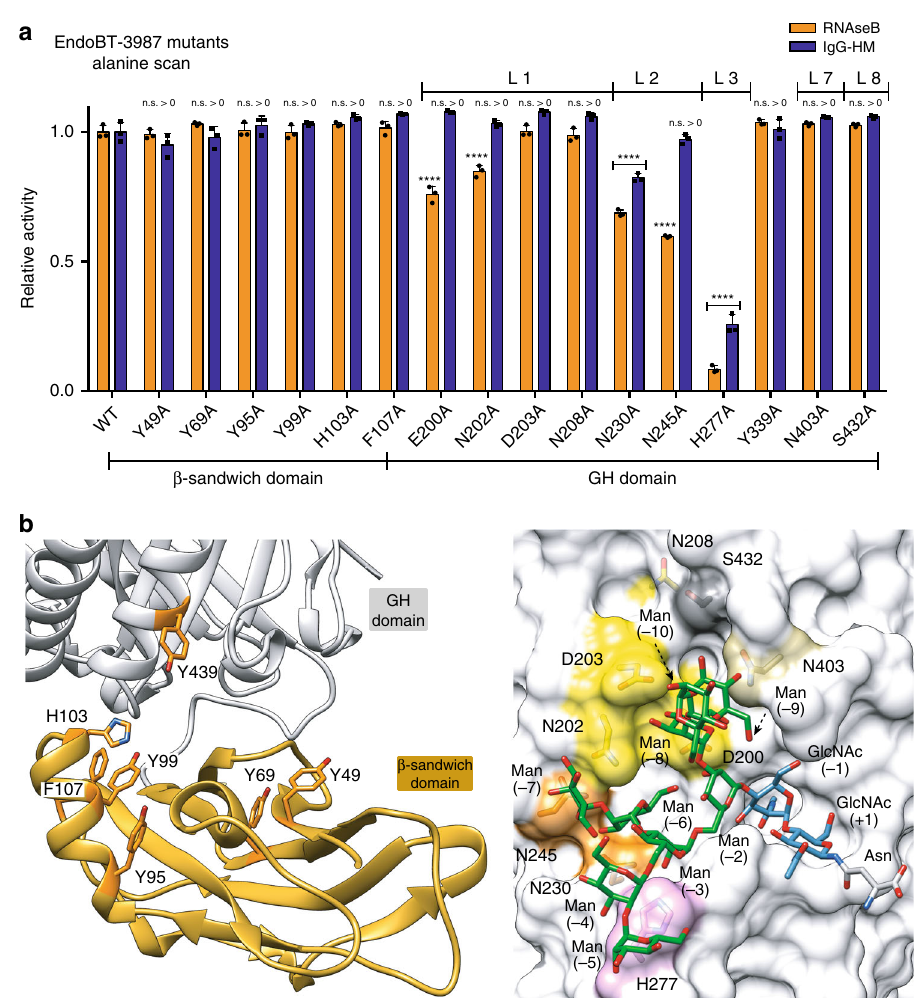
Fig. 4 Alanine scan mutagenesis of EndoBT-3987 active site for HM IgG1 and RNaseB. a Hydrolytic activity of EndoBT-3987 and mutants against HM- IgG1 and RNaseB is shown, as determined by LC-MS analysis, normalized to EndoBT-3987 WT . Statistical signi fi cance compared with wild-type EndoBT is annotated (multiple comparisons test, Tukey method; * p < 0.05; ** p < 0.01; *** p < 0.001, **** p < 0.0001, n.s. > 0, not signi fi cantly greater than no-enzyme control). Source data are provided as a ‘ Source_Data_File_Fig_4a ’ . b In the left panel cartoon representation of the β -sandwich domain. The mutated residues are highlighted in oranges. In the right panel surface representation of the EndoBT-3987 D312A/E314L -Man 9 GlcNAc 2 Asn crystal structure showing the alanine mutations performed in loop 1 (yellow), loop 2 (orange), loop 3 (pink), loop 7 (brown), and loop 8 (gray) in the glycosidase domain